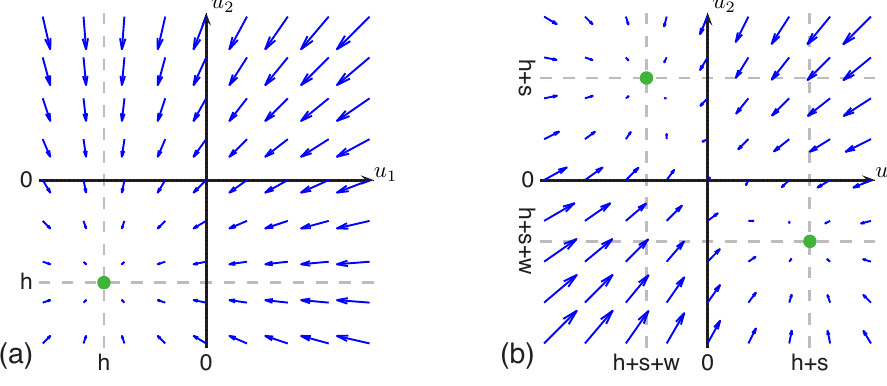
Figure 12: Phase plot of two activation variables in a two-dimensional state space. The vectors indicate the direction and magnitude of the rate of change at the state where they start. Panel (a) shows the case without external stimulus with one fixed point attractor (green dot), while in panel (b) the external stimulus is active, resulting in two fixed point attractors.